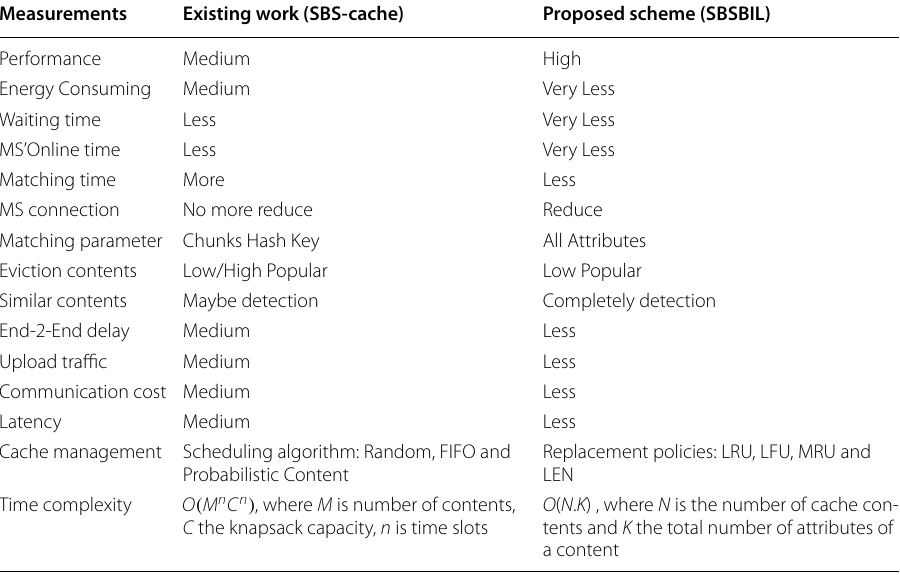
Table 4 Differential between the proposed scheme and existing work Measurements Existing work